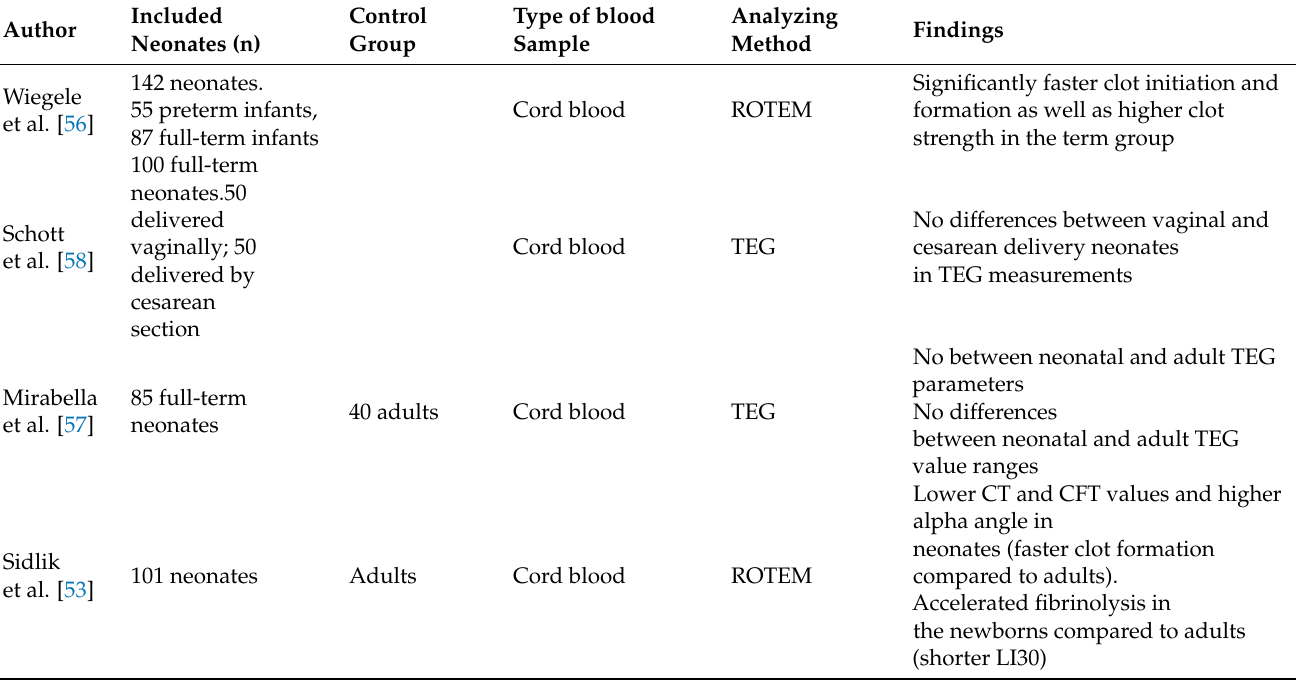
Table 5. Main TEG®/ROTEM®results obtained in the healthy neonatal population: study